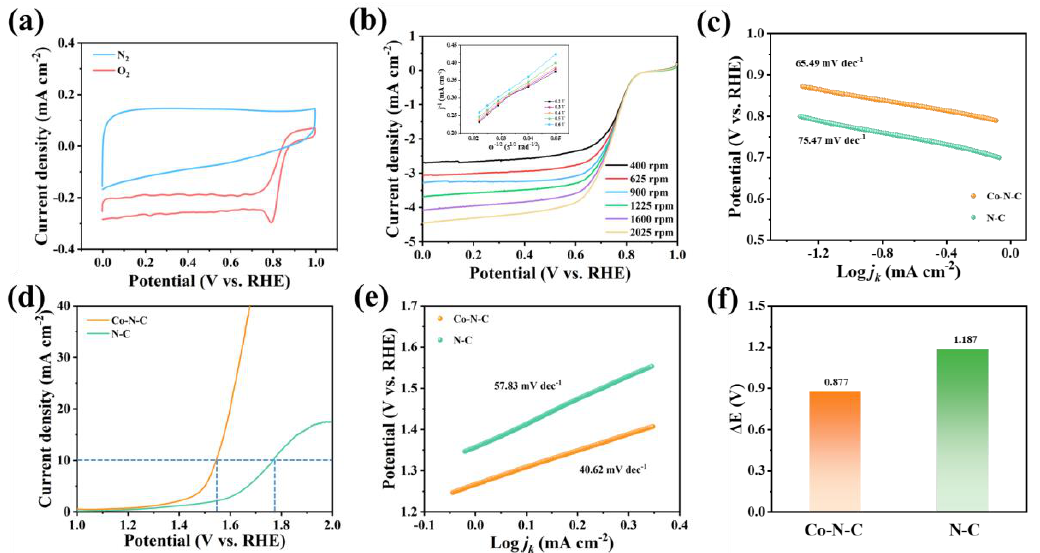
Figure 4. ( a ) CV curves of Co−N−C of ORR in the N 2 −/O 2 −saturated KOH (0.1 m). ( b ) LSV curves of ORR at different rotational rates (r.p.m.) and corresponding K−L plots (inset section) of Co−N−C. ( c ) Tafel plots of ORR. ( d ) OER LSV polarization curves. ( e ) Tafel plots of ORR. ( f ) The overall potential gap (ΔE) between the OER potential measured at a current density of 10 mA cm −2 and the ORR half−wave potential (ΔE = E j10 − E 1/2 ).